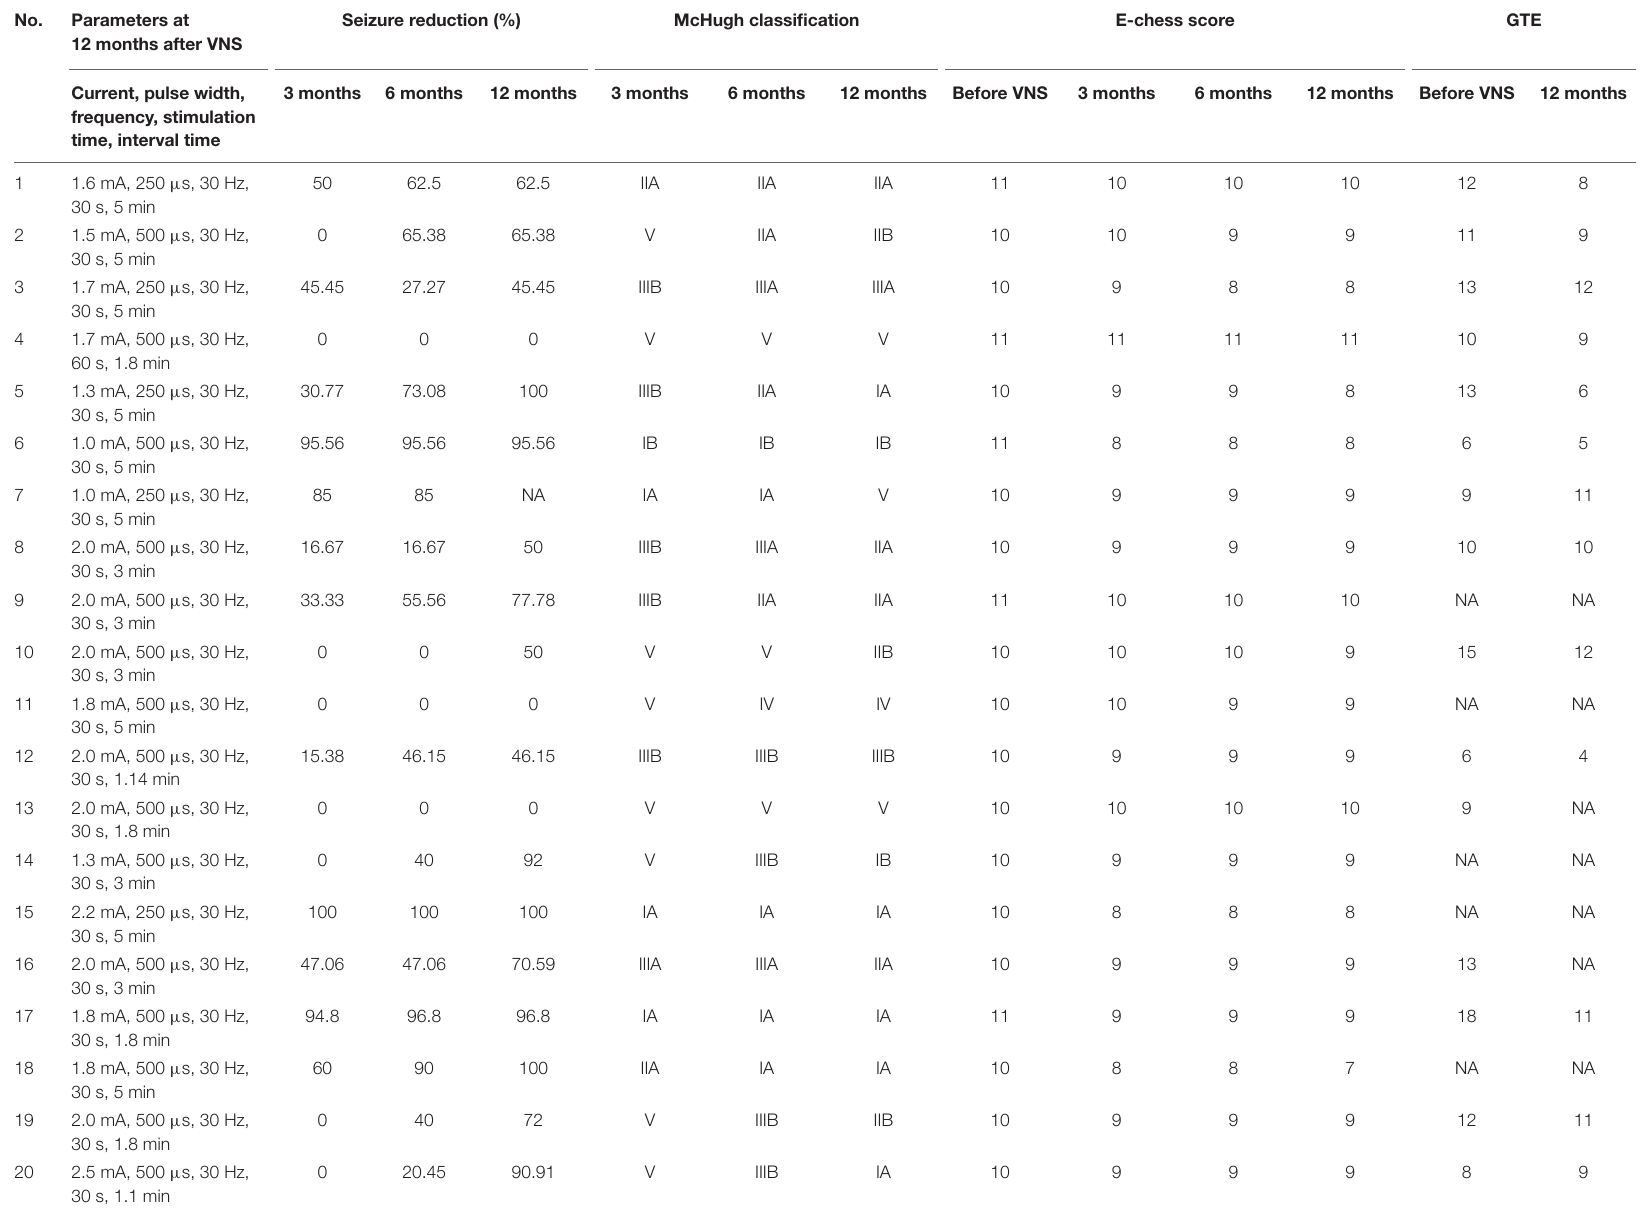
TABLE 1 | Efficacy of VNS for each patient.